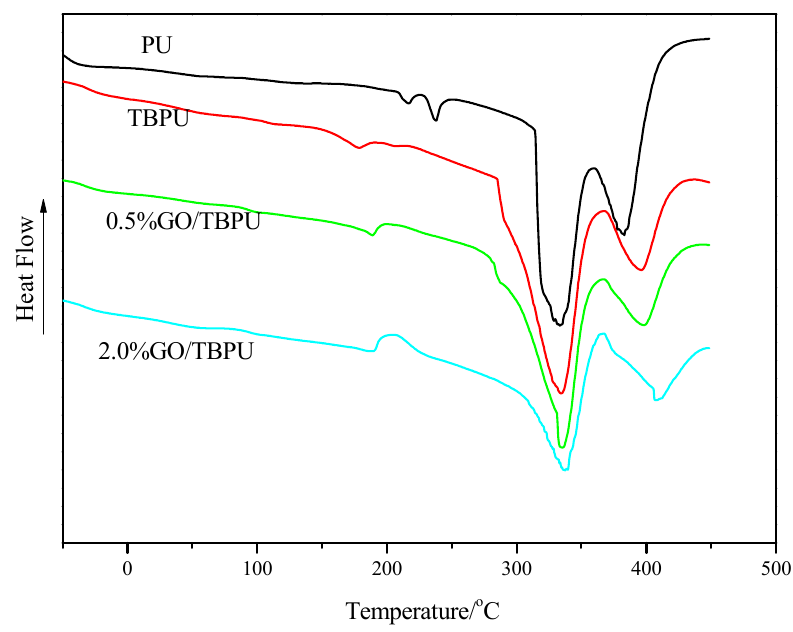
Figure 3. Comparison between DSC thermograms of PU, TBPU, and GO-TBPU.